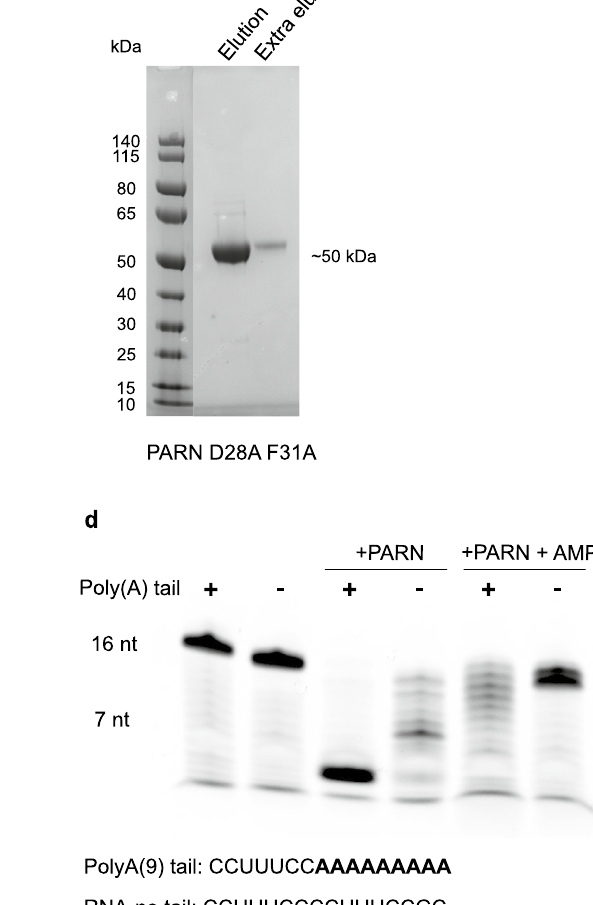
Figure 2. PARN purification and validation. ( a ) SDS-PAGE gel of the fractions during PARN 1-430 purification. ( b ) SDS-PAGE gel of the fractions during PARNmut purification. ( c ) Gel assay showing PARN 1-430 and PARNmut’s activity activity on poly(A) tail RNA at different time points (0-, 10-, 20-, and 30-min post incubation), PARNmut shows no enzymatic activity on poly(A) RNA. ( d ) Representative gel confirming PARN activity on poly(A) RNA and non-poly(A) RNA after 20 min of incubation. Poly(A) tail RNA sequence is a fluorescently labeled RNA with a CCU UUC C followed by a 9 nucleotides oligo(A) tail. Non-poly(a) RNA is a fluorescently labeled RNA with a CCU UUC CGC tail instead of 9 nucleotides oligo(A) tail. Full gels are presented in Supplementary Fig.